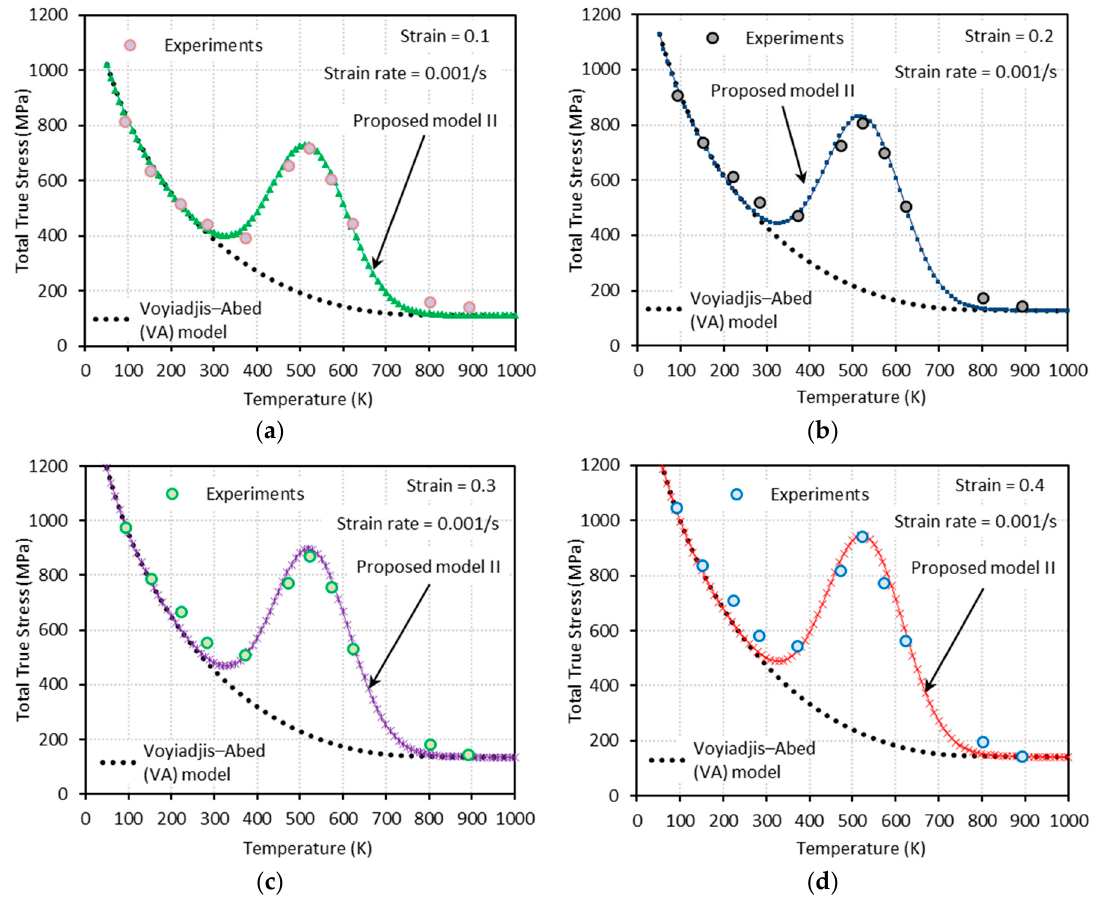
Figure 14. Comparisons between model predictions from the VA and proposed model II and experimental data from [1] on the total true stress versus temperature responses at ( a ) ε = 0.1, ( b ) ε = 0.2, ( c ) ε = 0.3, and ( d ) ε = 0.4. Quasi-static loading with 0.001 s − 1 is applied.